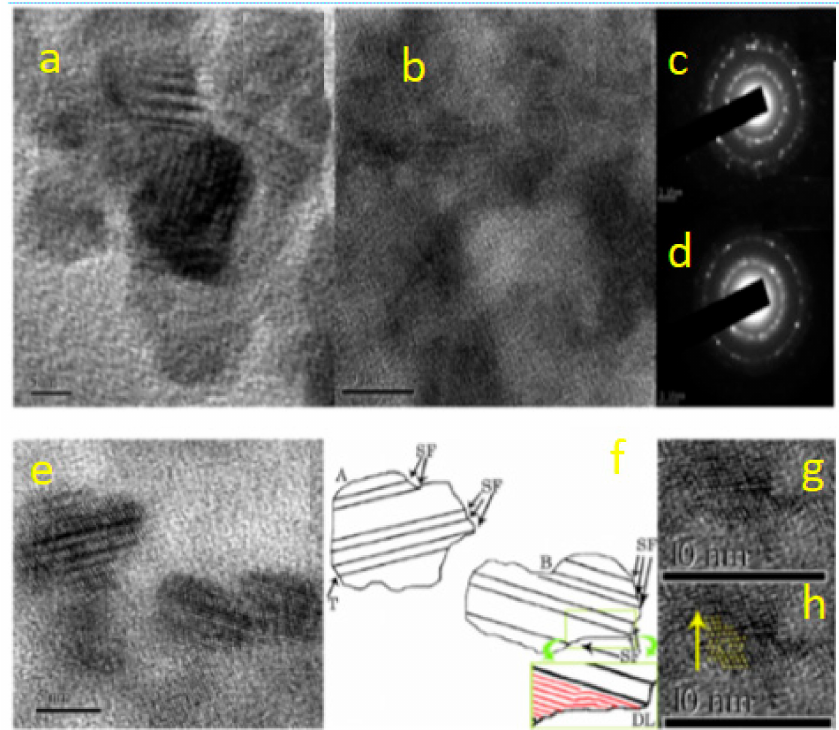
Figure 6. HRTEM images and SAED patterns of CuS-PVP nanoparticles (NPs) ( a ) and ( c ) and QDs ( b ) and ( d ). HRTEM image of CuS-PVP QDs showing abrupt edges ( e ). Dislocations, twins, and stacking faults are illustrated in ( f ). A twin region formed between the cubic and hexagonal phases of CuS is illustrated in ( g ) and ( h ). The stacking sequence is determined as ABCABABCAB in the direction indicated by the arrow (reproduced from ref. [69] with permission from the American Chemical